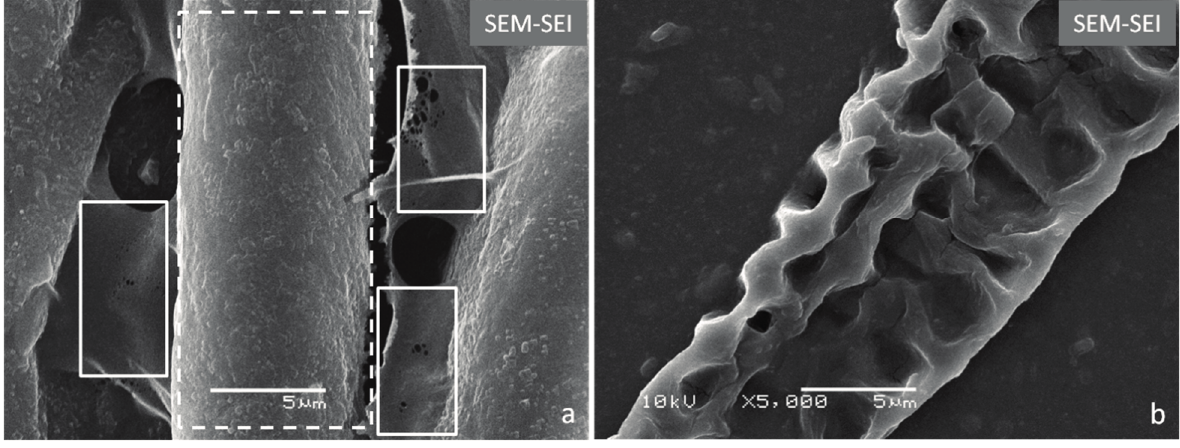
Figure 1. Scanning electron micrographs of the Citrus-waste Biomass (CB) before and after enzymatic treatment: ( a ) CB sample pretreated with NaOH (4% w/v) at 120 °C for 20 min and NaClO 2 (1.7% w/v) for 30 min at 120 °C and pH 4.5; ( b ) CB sample pretreated as in (a) and after Xanthomonas axonopodis pv. citri enzymatic action for 48 h at 45 °C at pH